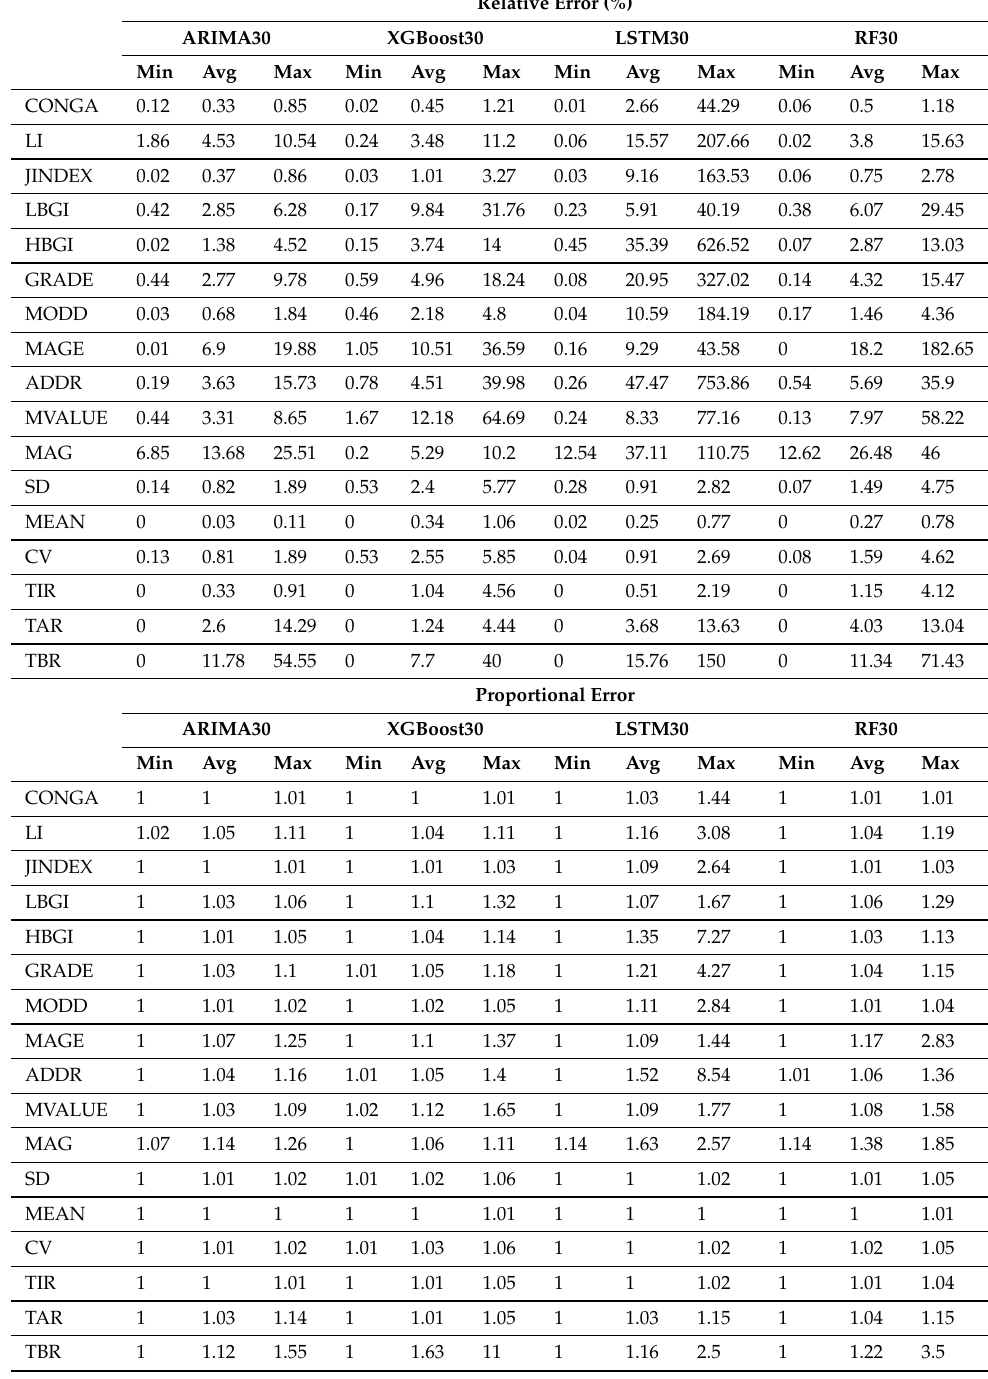
Table 6. Relative and proportional errors for glucose variability metrics calculated using 48 h of glucose profiles predicted using ARIMA, Gradient Boost, LSTM, and Random forests models employing 30 days of training